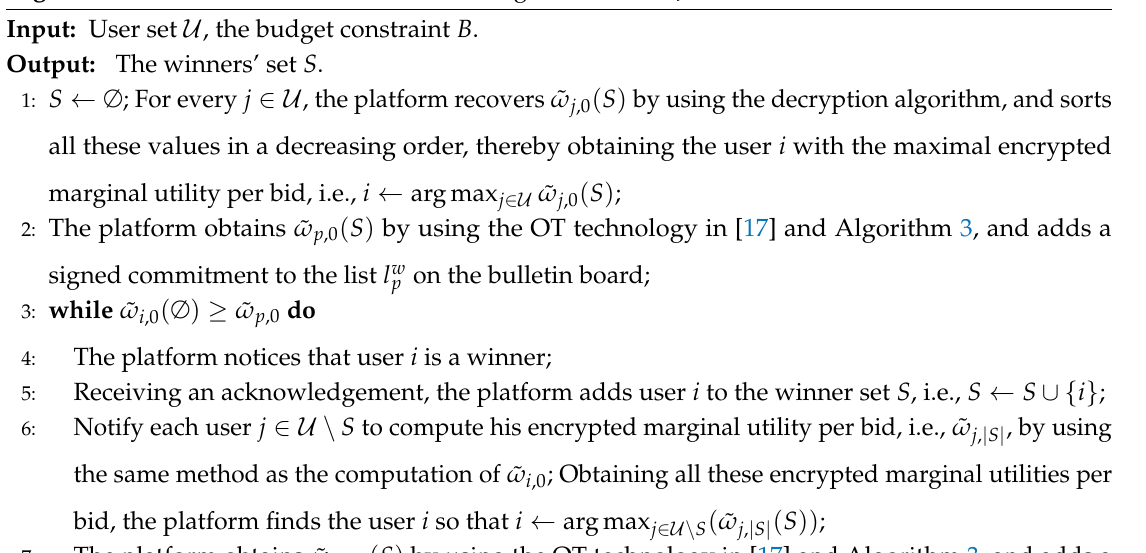
Algorithm 5 Winner Determination for Sensing Submodular